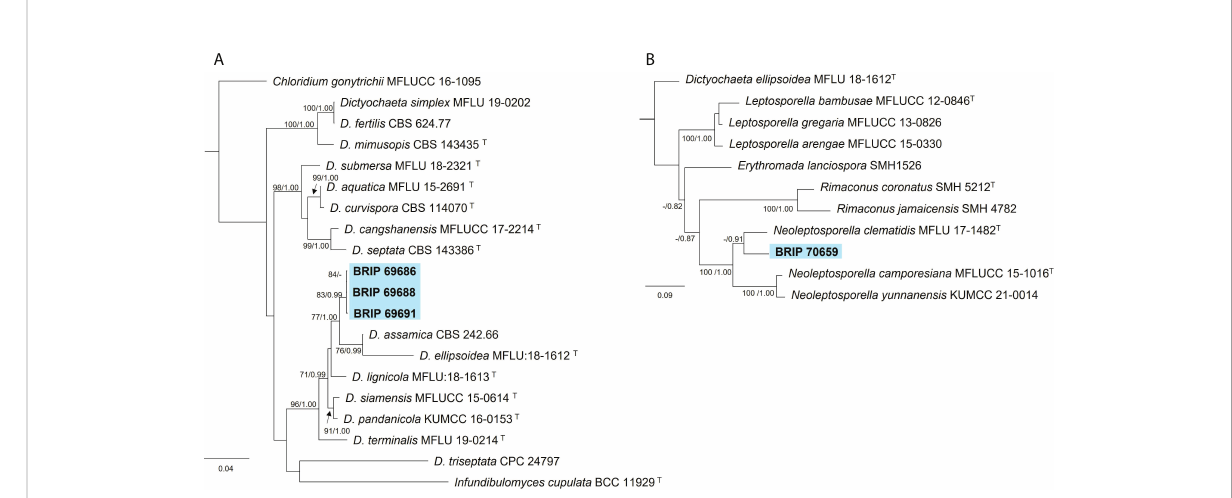
FIGURE 4 Phylogenetic trees inferred from RAxML analyses of strains in Chaetosphaeriales based on concatenated alignments of (A) ITS, LSU and tef1- a sequences of related species in Chaetosphaeriaceae; and (B) ITS and LSU sequences of related species in Neoleptoporella ( incertae sedis ). RAxML bootstrap (bs) values greater than 70% and Bayesian posterior probabilities (pp) greater than 0.8 are given at the nodes (bs/pp). In bold font are the isolates from this study, and ex-type strains are indicated with T